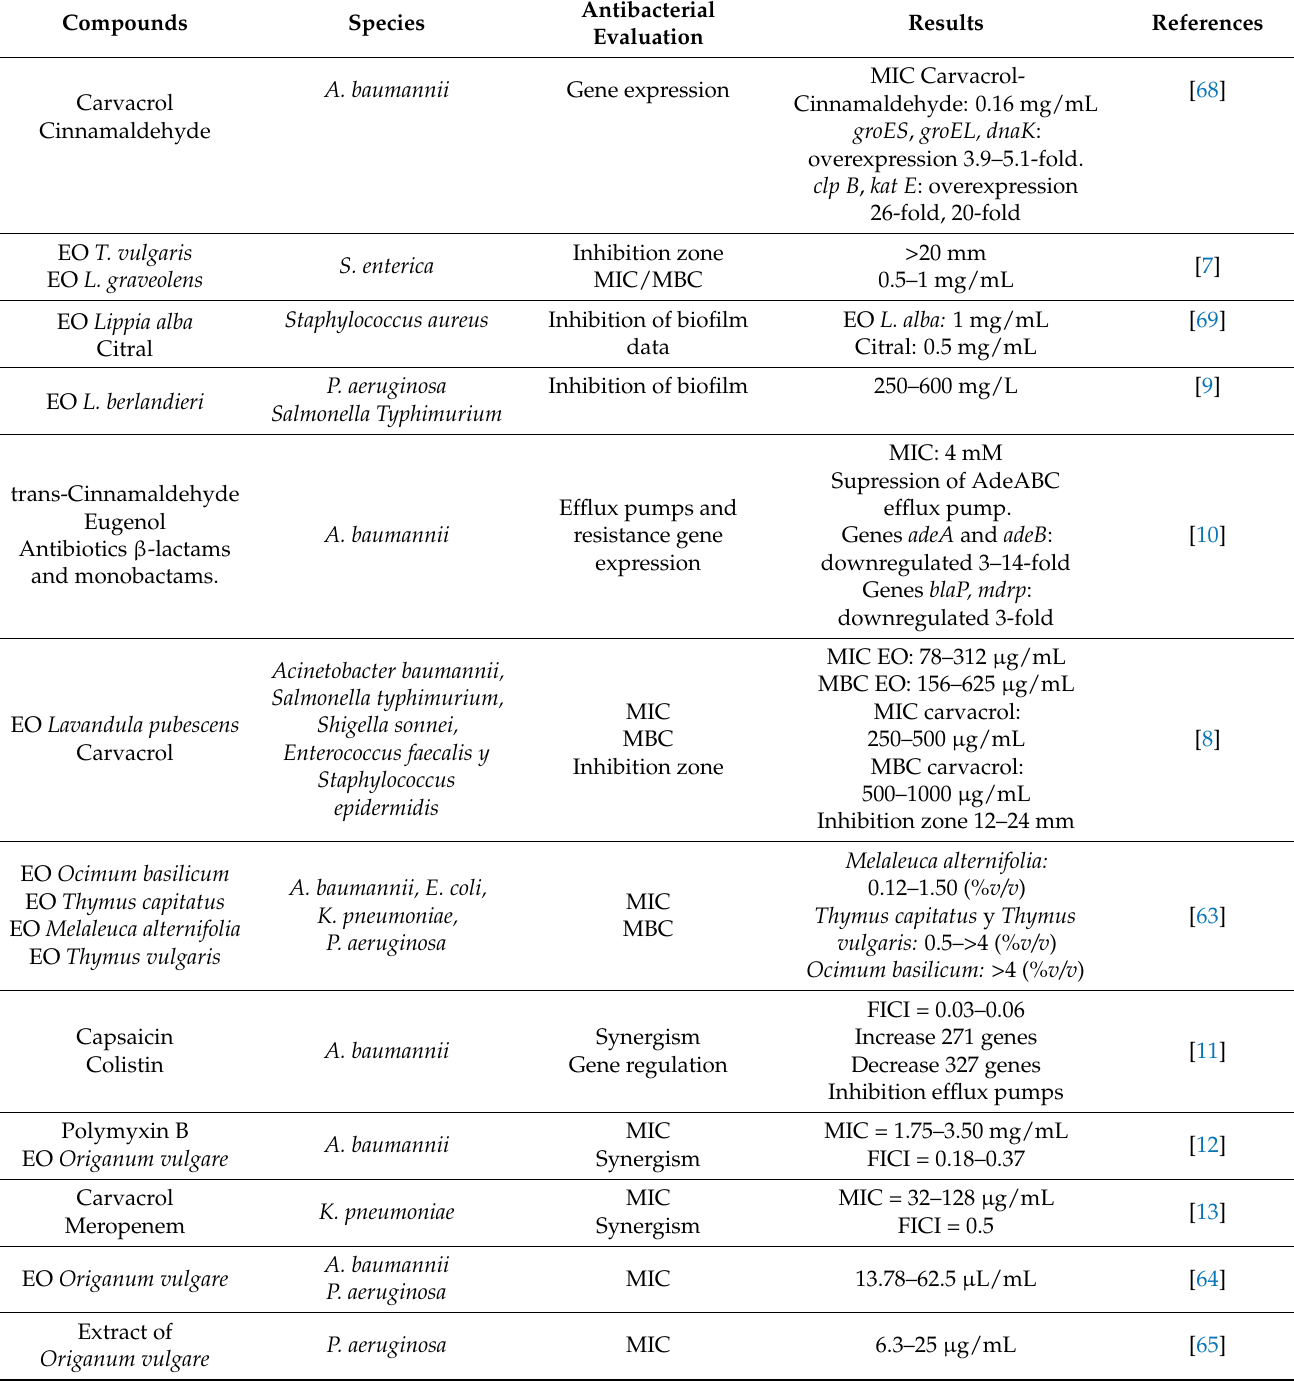
Table 2. Previous studies on the antibacterial activity of essential oils, their constituents, and